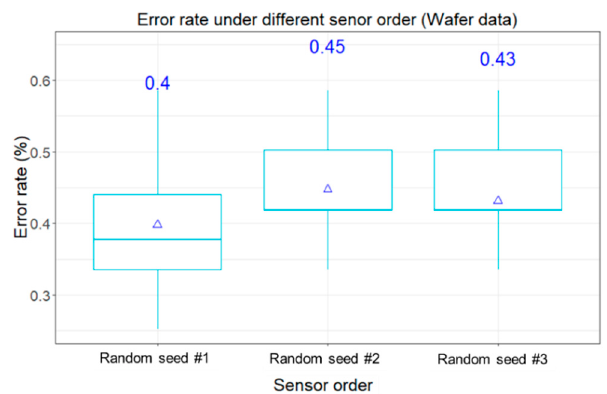
Figure 6. The boxplot of error rates of classification by using the MTF RGB images as inputs under different random sequences (Wafer dataset). di ff erent random sequences (Wafer dataset).